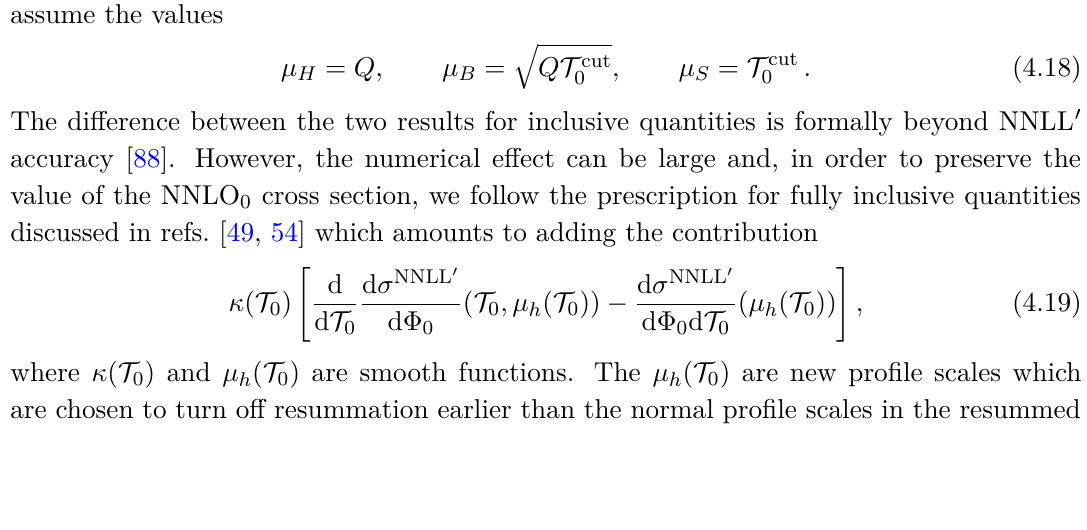
JHEP04(2021)041